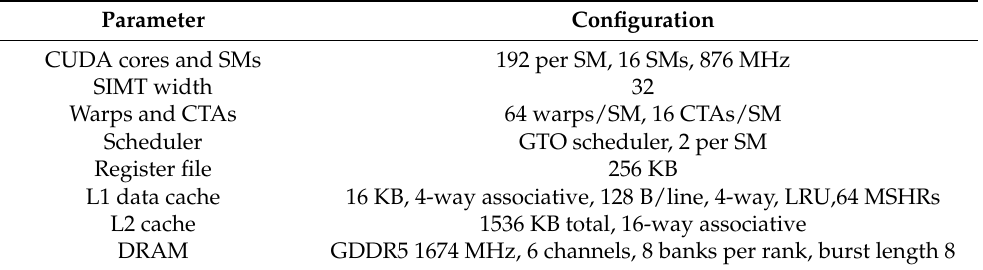
Table 2. GPGPU-sim baseline